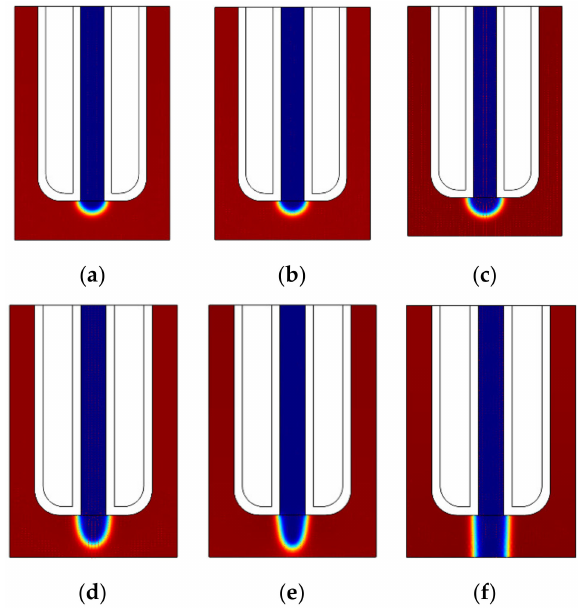
Figure 8. Simulation results at di ff erent voltages. ( a ) 50 V. ( b ) 100 V. ( c ) 0.5 kV. ( d ) 1 kV. ( e ) 1.5 kV. ( f ) 2